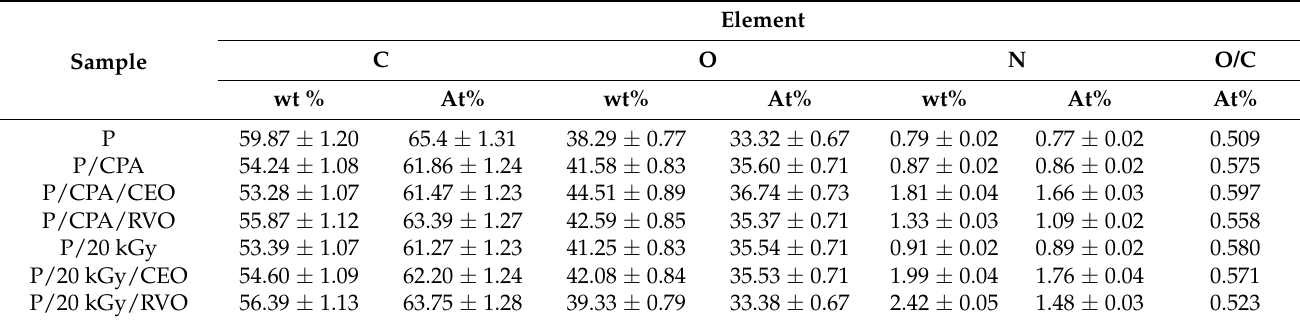
Table 2. EDAX data expressed in weight (wt) and atomic (At) content for kraft paper treated with plant oils compared with the unmodified one.